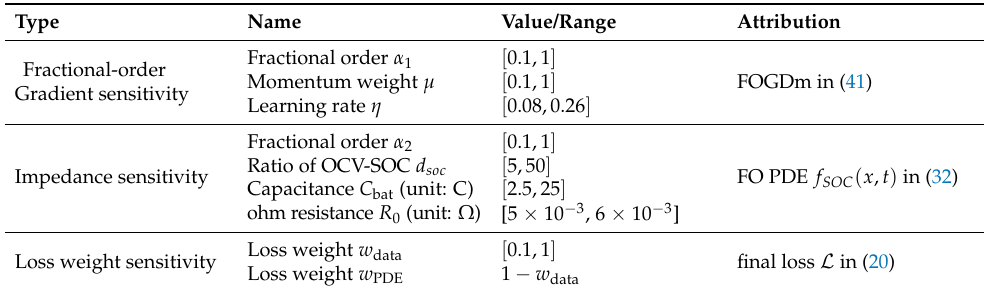
Table 3. Sensitivity categories of the fractional-order constraint and the fractional-order gradient in the proposed algorithm.